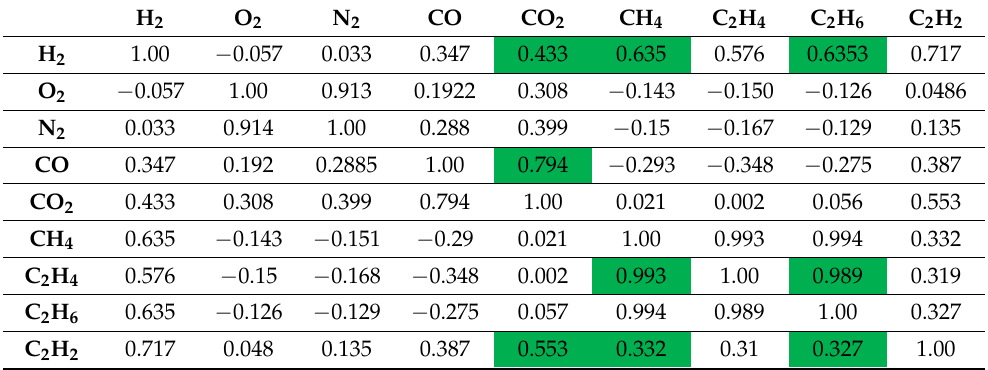
Table 23. Correlation between gases measured by specialized laboratory ( offline ). The green color marks a strong correlation between some gases.